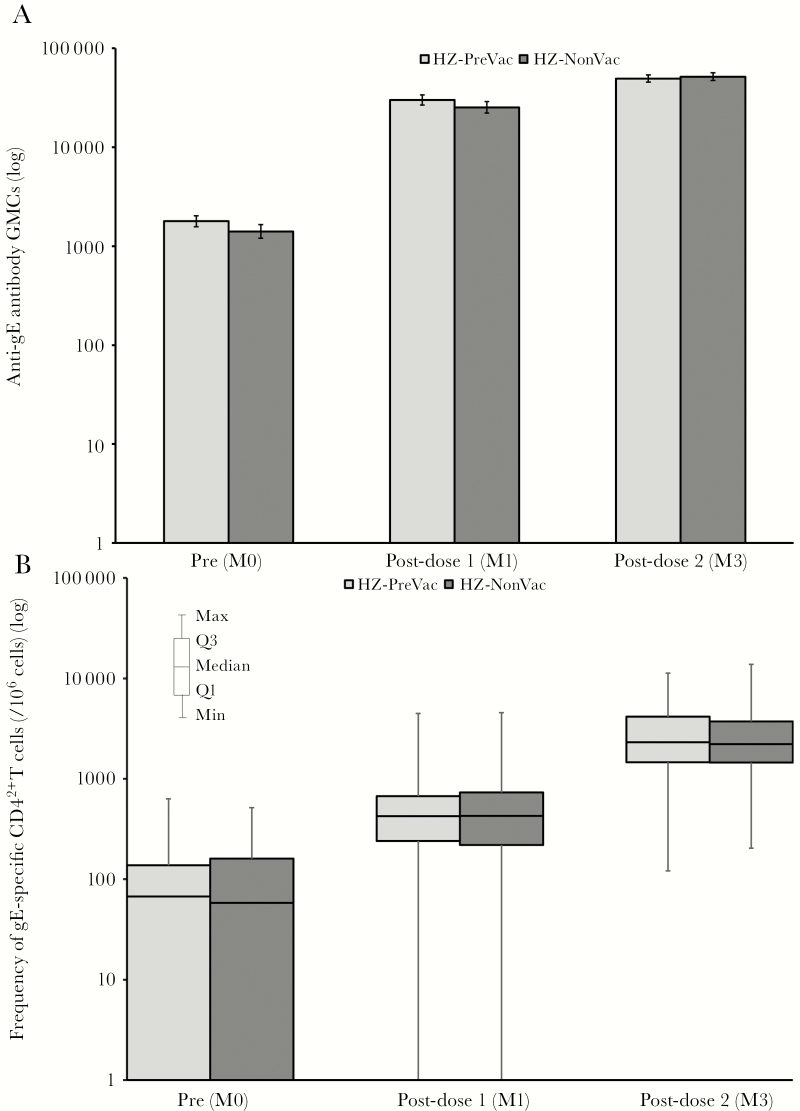
Humoral and cellular immune response to herpes zoster subunit candidate vaccine (HZ/su) (according to protocol cohort for immunogenicity). A, Humoral immune response to HZ/su vaccination. Anti–glycoprotein E (gE) antibody concentrations were determined by enzyme-linked immunosorbent assay. Data are geometric mean concentrations (GMCs [mIU/mL]) and error bars indicate 95% confidence intervals. B, Cellular immune response to HZ/su vaccination. The gE-specific CD4+ cells expressing at least 2 activation markers (CD42+) were determined by intracellular staining and flow cytometry. Data are median cell counts per 106 total peripheral blood mononuclear cells. Light bars indicate participants who received the live attenuated zoster vaccine ≥5 years prior to study start (HZ-PreVac group); dark bars indicate participants who never received the live attenuated zoster vaccine (HZ-NonVac group). Abbreviations: M0 = pre vaccination; M1, one month post-dose 1; M3, one month post-dose 2.